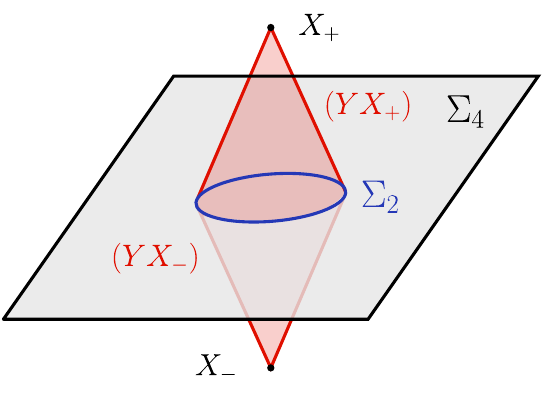
Figure 2 . Illustration of the geometry of the intersection of the integration cycle (cid:6) 4 and the light-cones ( Y X (cid:6) ) = 0. (cid:6) 2 is the cycle that the di(cid:11)erential of the d log integral localizes